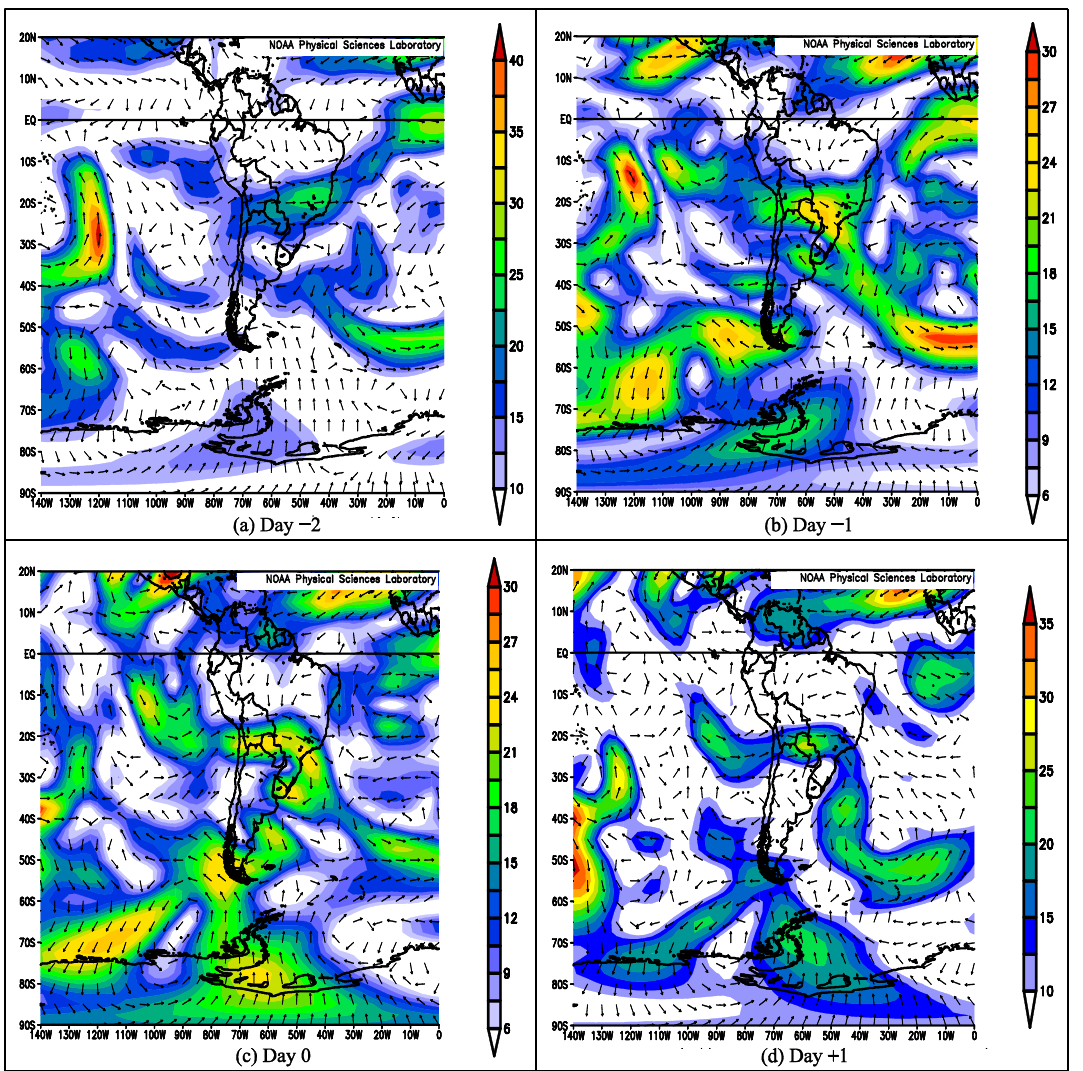
Figure 12. Wind composite anomaly (m/s) at high levels of the atmosphere (200 hPa) for ( a ) day − 2, ( b ) day − 1, ( c ) day 0, and ( d ) day +1 of the rainfall event on 15 January 1970. Source: NOAA/ESRL Physical Sciences Laboratory. The climatology base period is 1980 – 2010.